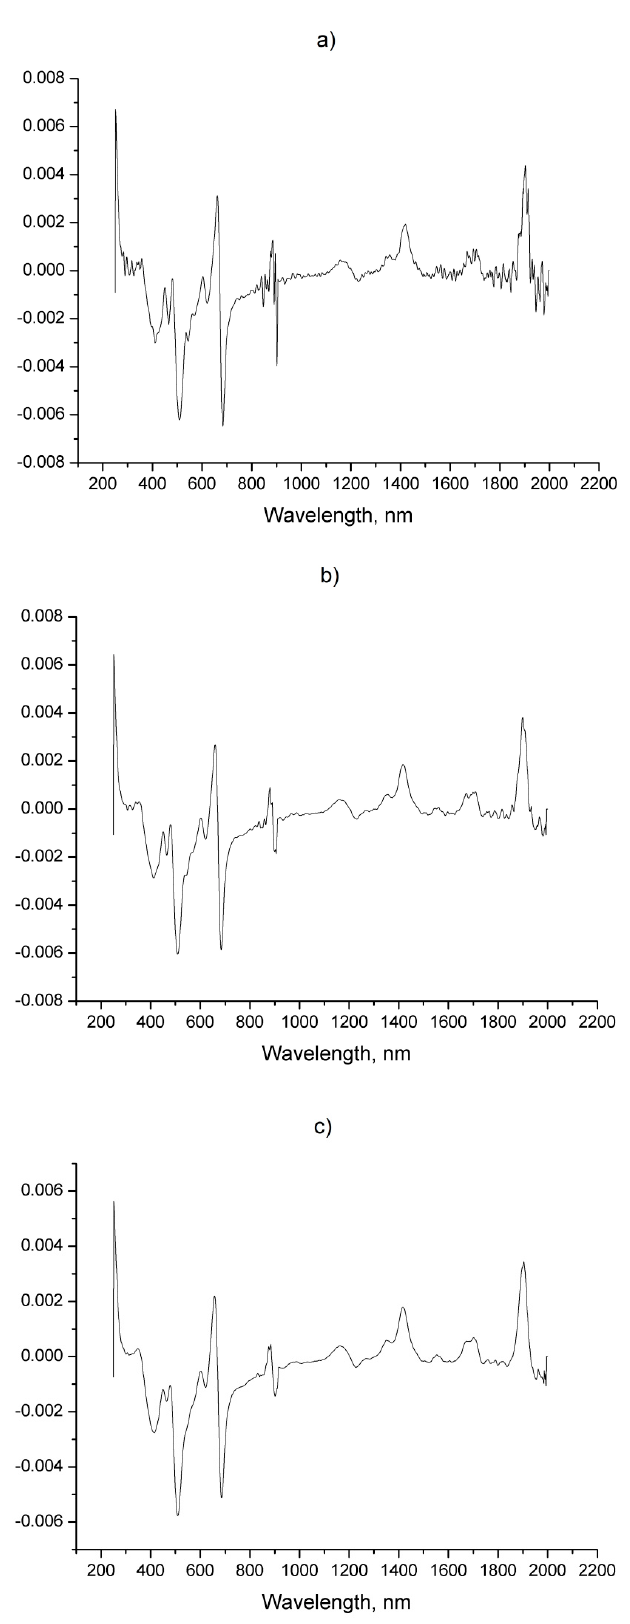
Figure 3. First derivative spectra obtained with Golay-Savitzky method: ( a ) 5-points; ( b ) 10 points; ( c ) 15 points filter window.